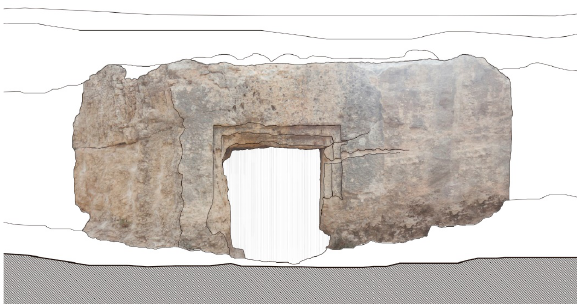
Figure 3. Tomb façade: main section of the entrance.